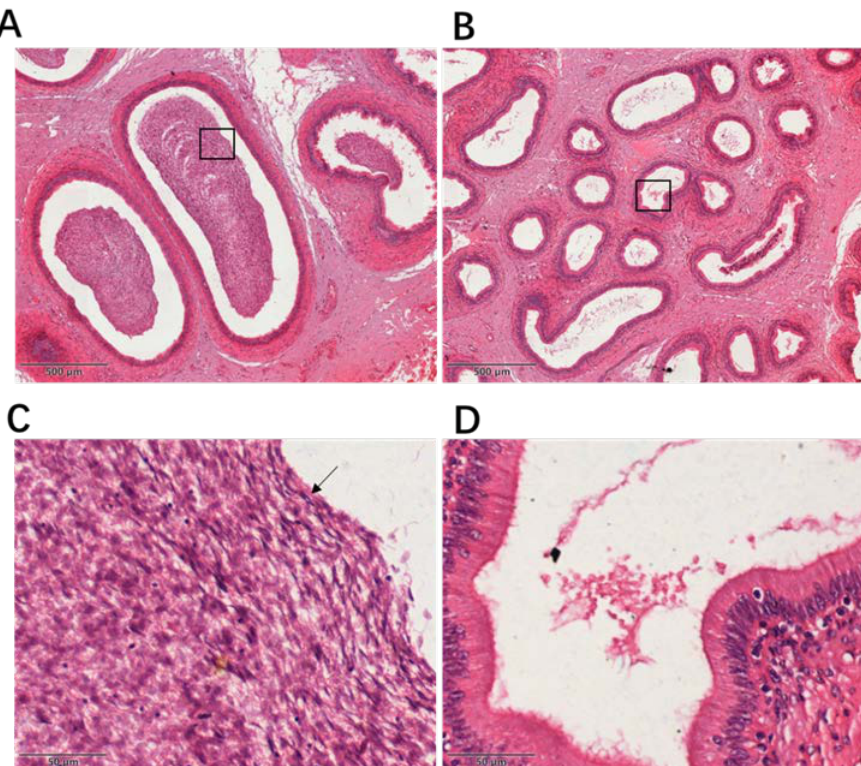
Figure 1. Histological examination of the epididymis in yaks and cattle–yaks. Magnification: 40× (images A, B), 400× (images C, D). ( A ) Sections of H&E-stained yak epididymis. ( B ) Sections of H&E-stained cattle–yak epididymis. ( C ) Enlargement of the part of image A framed by the black rectangular box. The arrow indicates the yak sperm. ( D ) Enlargement of the part of image B framed by the black rectangular box.